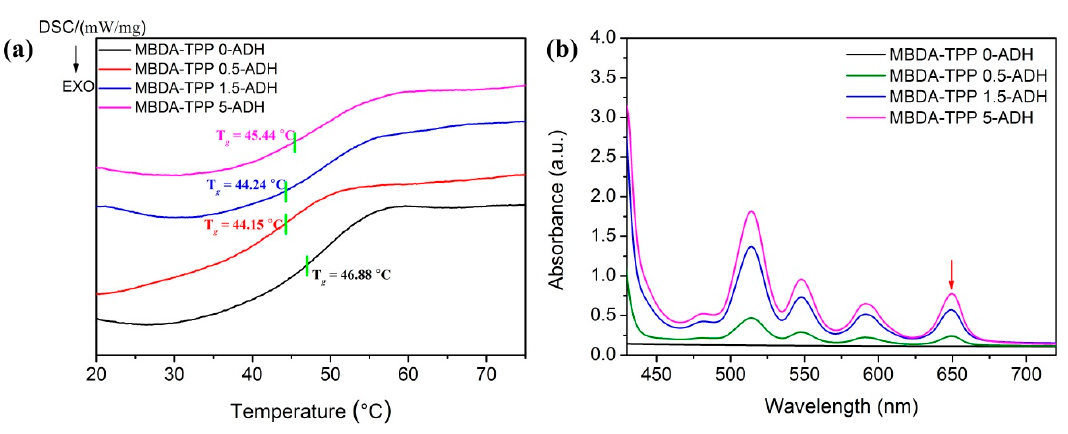
Figure 4. Characterizations of MBDA–TPP–ADH films with different TPP doses: ( a ) DSC traces; ( b ) UV–Vis absorption spectrum.